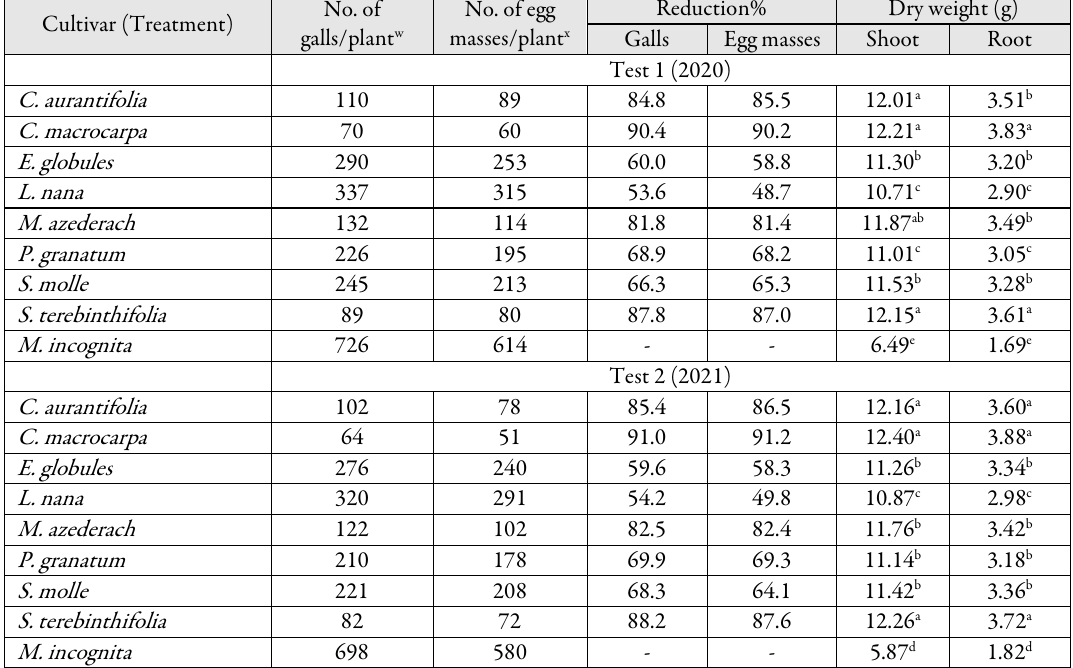
Table 3. Effects of soil amendment with dried plant materials of Citrus aurantifolia , Cupressus macrocarpa , Eucalyptus globules , Lantana nana , Melia azedarach , Punica granatum , Schinus molle and S. terebinthifolia on Meloidogyne incognita reproduction on spinach cv. ‘Balady’ Cultivar